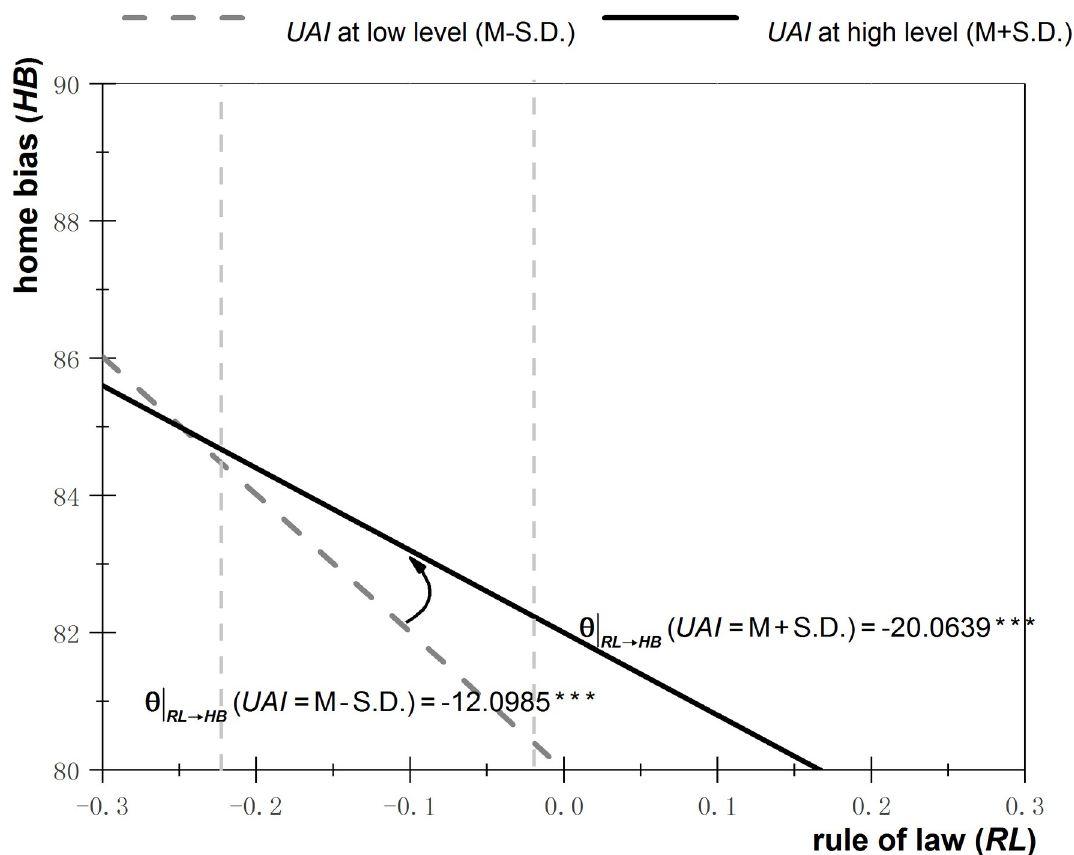
Fig 3. Effects of the rule of law on home bias under different degrees of uncertainty avoidance.